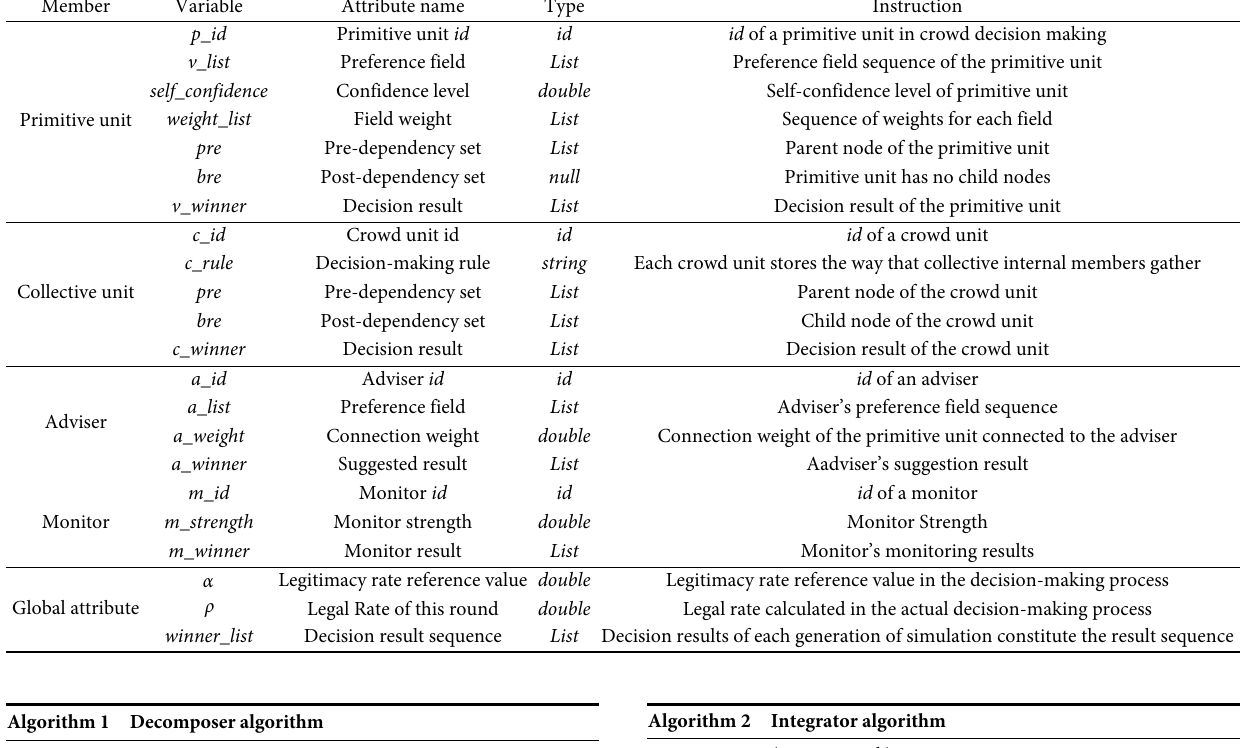
Table 3 Simulation member attributes setting.